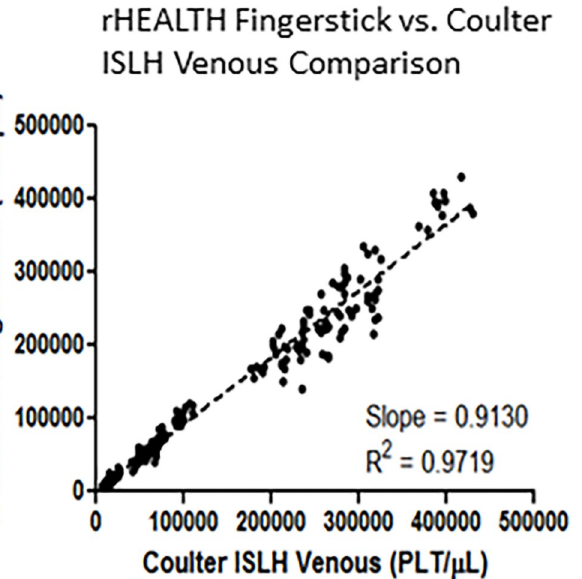
Fig 3. Correlation plot of Coulter ISLH venous platelet counts versus rHEALTH fingerprick platelet counts using absolute volumetric method. Platelet concentrations for both are in plt/ μ L and the trend line equation and R 2 are